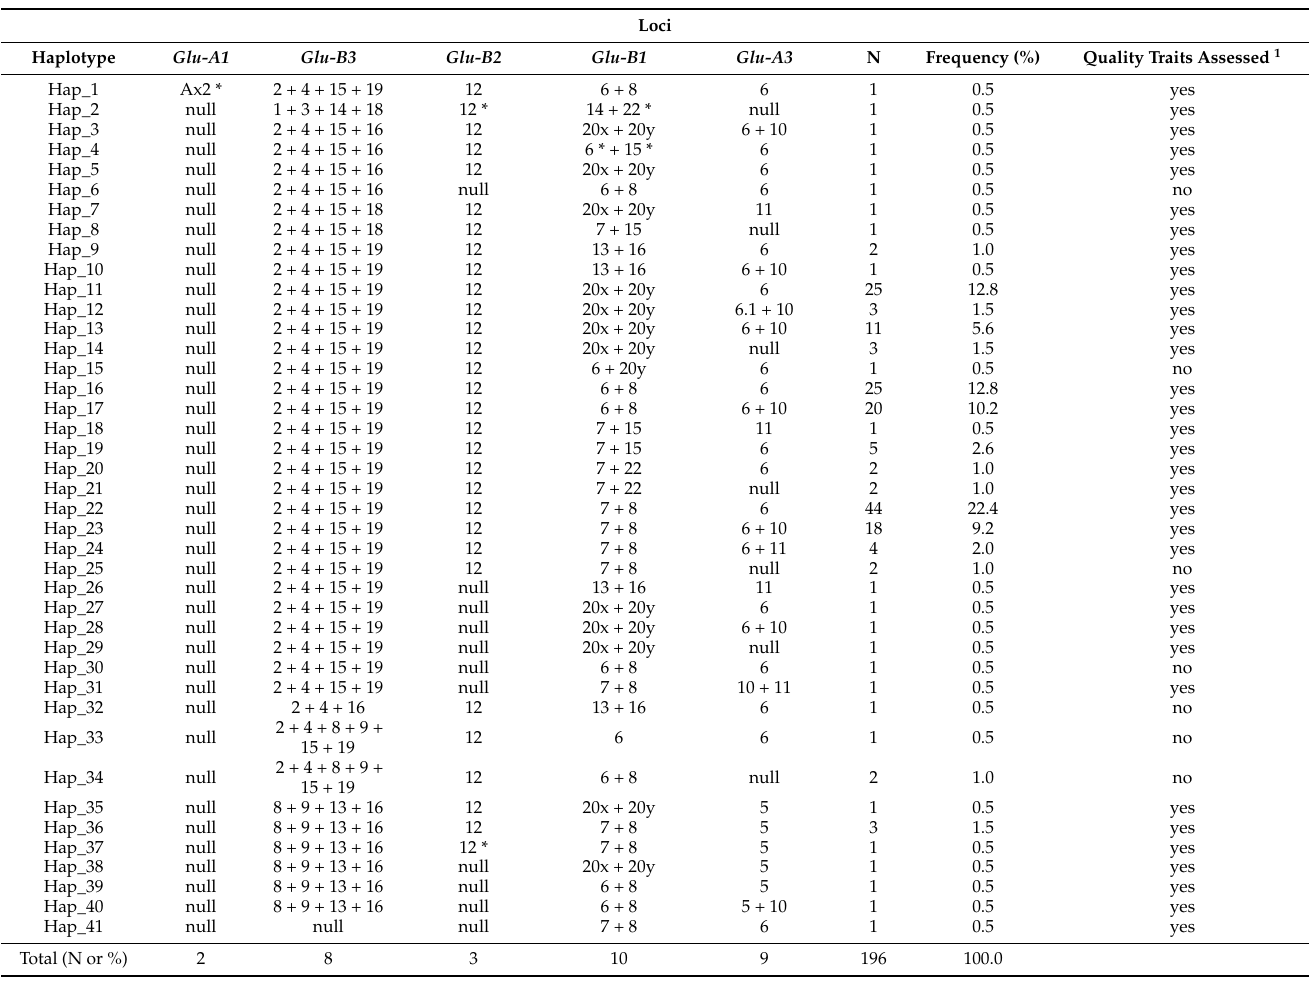
Table 2. Frequency and allele composition of haplotypes for HMW-GS and LMW-GS detected in a worldwide collection of durum wheat.